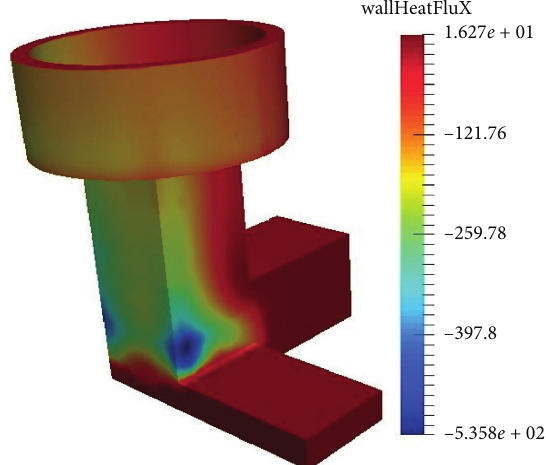
Figure 15: Wall heat flux of fire stove.